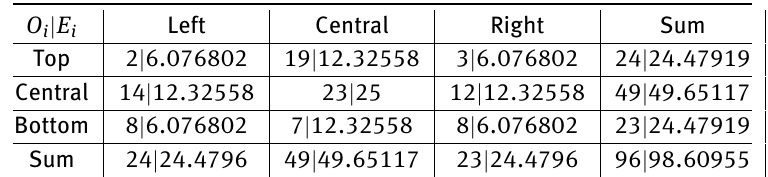
Table 3: Observed and expected values for the data from ( U , V ) in Example 2.2 and the regions determined by the empirical BBP in option 1. b